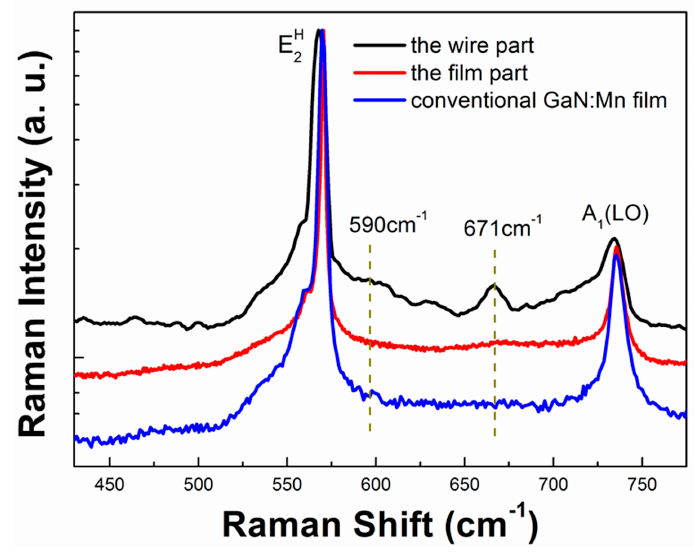
Figure 5. Micro-Raman spectra of the wire part, the film part, and the conventional GaN:Mn film.